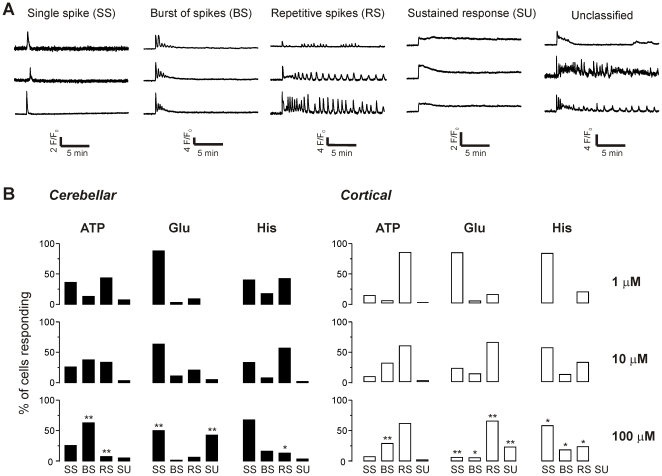
Classification of Ca2+ responses to long-term stimulation of astrocytes with agonists.
A) Representative traces of Ca2+ responses in each class: single spikes (SS), a burst of spikes (BS), repetitive spikes (RS) or a sustained increase in Ca2+ (SU), as well as responses that did not fall into any category (see Methods). B) The percentage of responses falling into each category is illustrated. Data for each agonist at each concentration are from 3–8 coverslips of cells, obtained from 2–3 culture preparations. The total number of responding cells for cerebellar astrocytes (left panels) n = 122 (1 µM ATP); 307 (10 µM ATP); 142 (100 µM ATP); 33 (1 µM glutamate); 101 (10 µM glutamate); 160 (100 µM glutamate); 40 (1 µM histamine); 51 (10 µM histamine); 31 (100 µM histamine). For cortical astrocytes (right panels) n = 138 (1 µM ATP); 118 (10 µM ATP); 128 (100 µM ATP); 93 (1 µM glutamate); 168 (10 µM glutamate); 468 (100 µM glutamate); 11 (1 µM histamine); 50 (10 µM histamine); 55 (100 µM histamine). Statistical significance of differences between the proportion of cells in each class due to concentration of agonist was tested for each agonist by Fisher's exact test. *p <0.05 or ** p <0.001 for 100 µM agonist versus 1 µM.